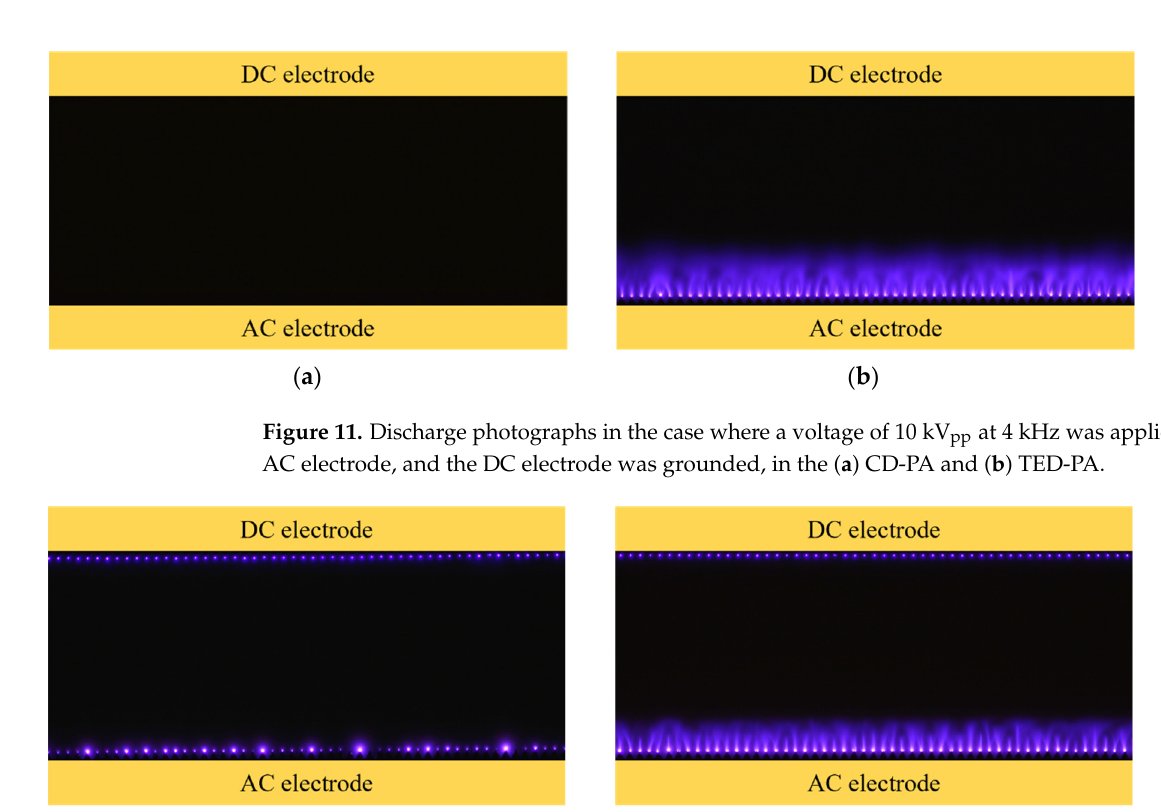
Figure 10. Discharge photographs in the case where the AC electrode was grounded and a voltage of 14 kV was applied to the DC electrode in the ( a ) CD-PA and ( b ) TED-PA.